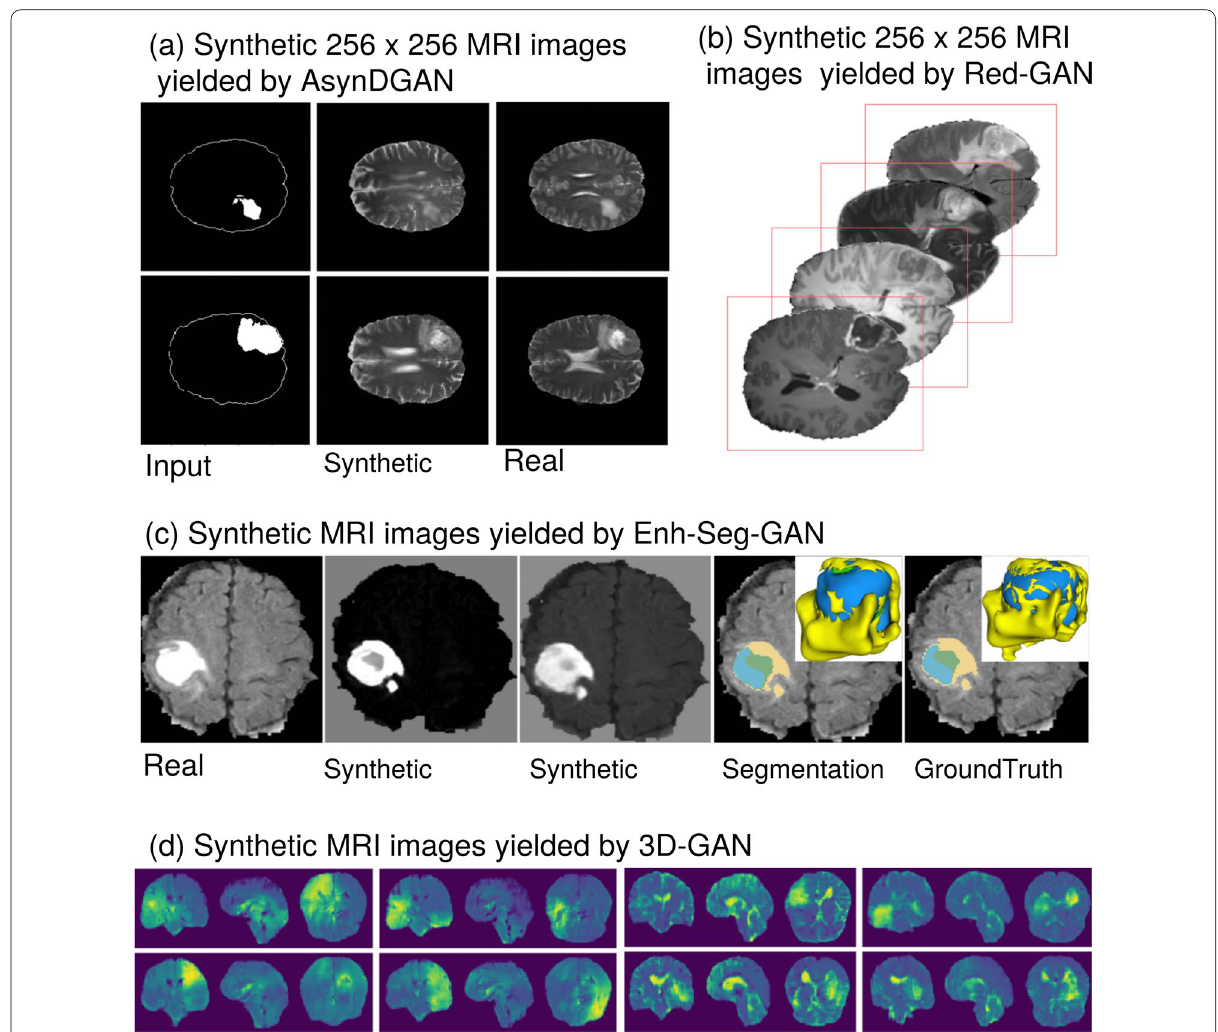
Fig. 9 Key generated samples for the examined studies. a The input of the AsynDGAN network, the generated sample and the corresponding real image [47, 48]. b Generated images conditioned on lesion masks [50]. c An example of generated images with the corresponding segmentation and groundtruth. The colors mean yellow: edema, blue: non-enhancing, and green: enhancing tumor. The 3D representation of the tumor is presented on the top right [56]. d Synthetic samples of severe cases of brain tumor, for better visualization the authors displayed color-mapped images where yellow indicates higher and blue indicates lower intensity